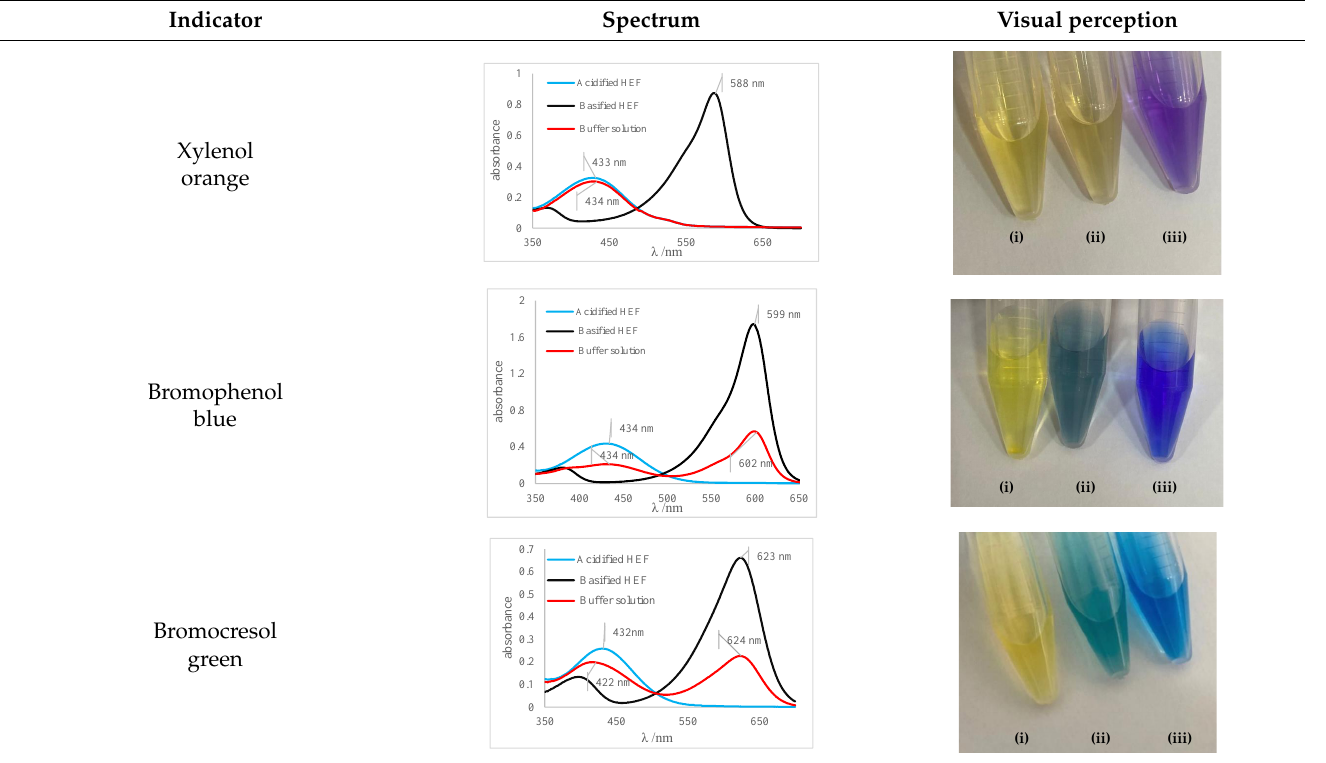
Table 9. Spectra and visual perception. Table 9. Spectra and visual perception . Table 9. Spectra and visual perception . Table 9. Spectra and visual perception . Table 9. Spectra and visual perception . Table 9. Spectra and visual perception . Table 9. Spectra and visual perception .